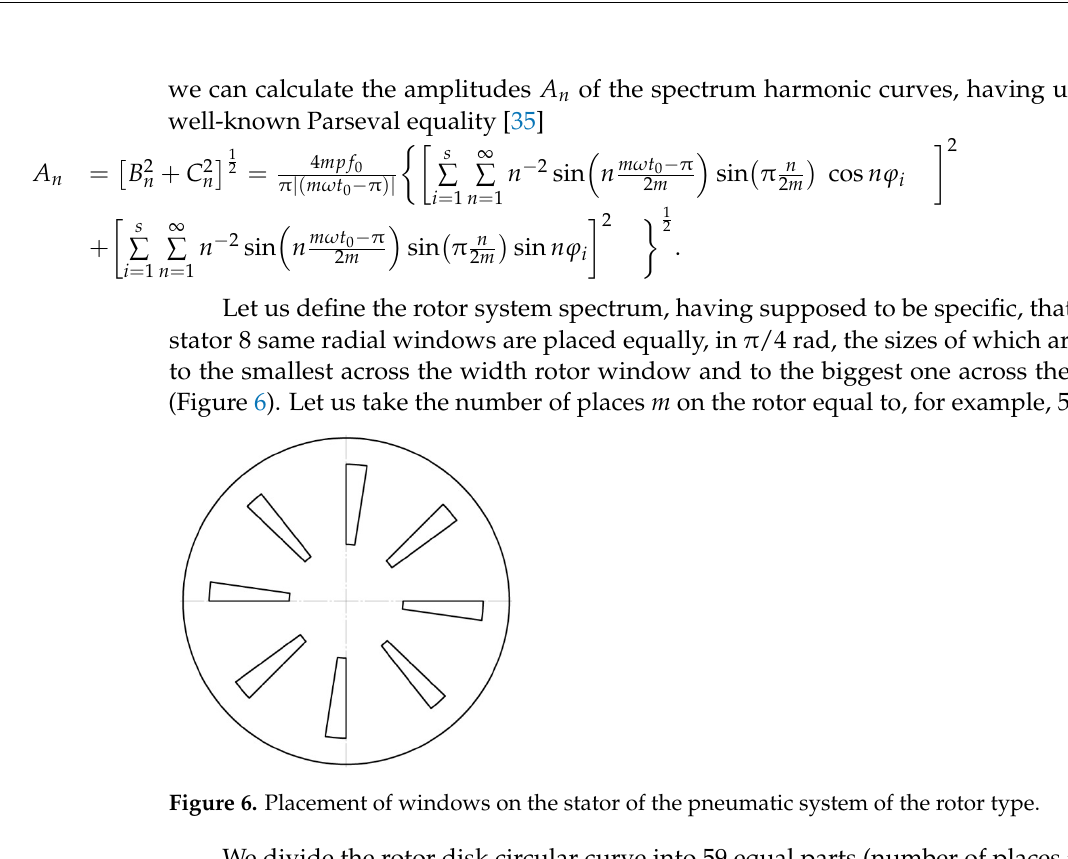
Figure 7. Placement of windows on the rotor of the pneumatic system: m = 59.